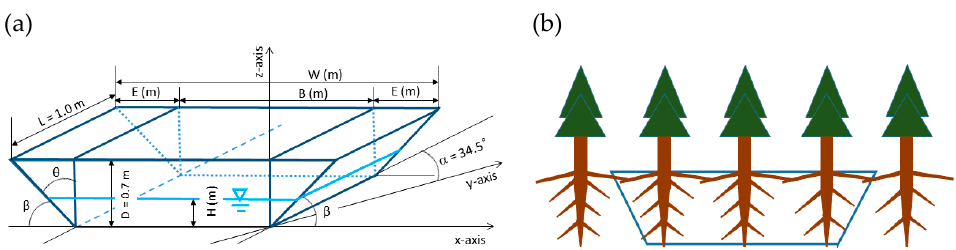
Figure 1. Schematic of the three-prism model used for slope-stability analysis. ( a ) Three prisms. ( b ) ( b ) Reinforcement by roots on a potential sliding Reinforcement by roots on a potential sliding surface.